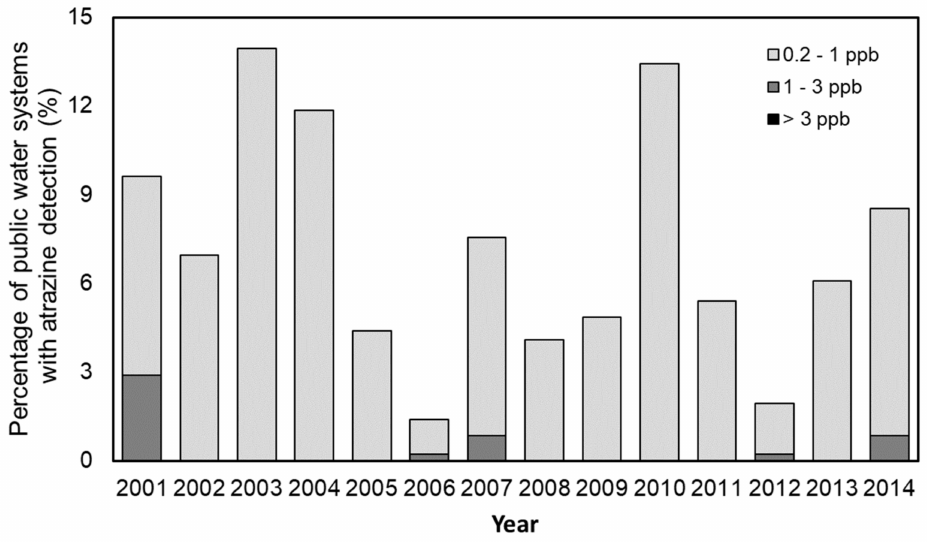
Figure 5. Percentage of public water systems by annual median atrazine category,